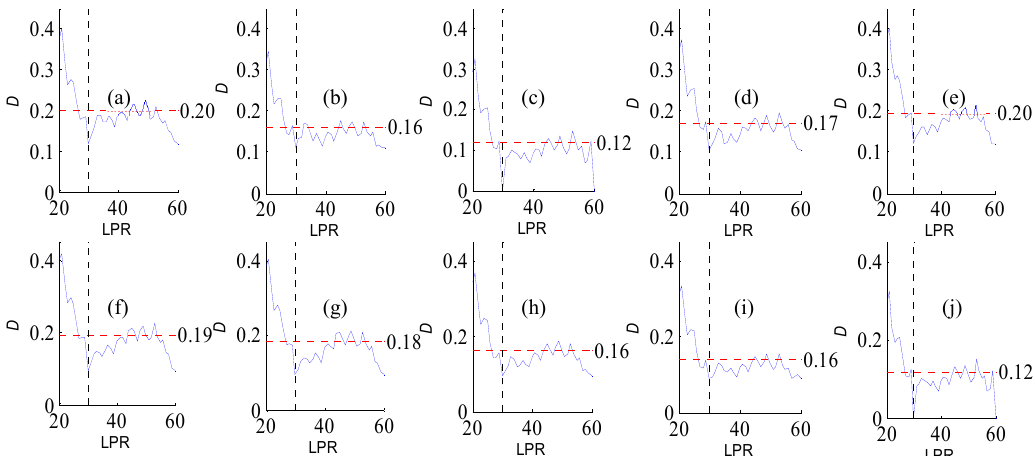
Figure A10. Variation of flow regime alteration degree (D) measured by the RVA with change in the length of post-impact flow time series (LPR) under a periodicity of 29 years. ( a ), ( b ), ( c ), ( d ), ( e ), ( f ), ( g ), ( h ), ( i ), and ( j ) correspond to pre-impact flow time series length = 21, 25, 29, 33, 37, 41, 46, 50, 54, and 58 years, respectively. The abscissa value for the vertical dotted line is 29. The ordinate value for the horizontal dotted line is the mean degree of flow regime alteration in each subfigure.